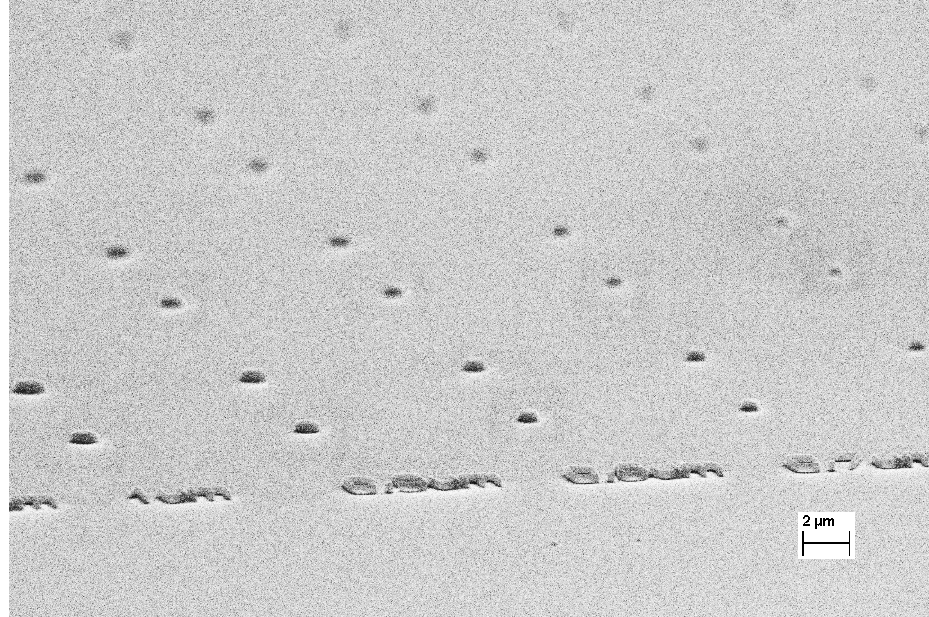
Figure 1. Array of structures for testing the process of fabrication submicron-sized tunnel junctions. The sample was located at an angle to the axis of the electron microscope probe.